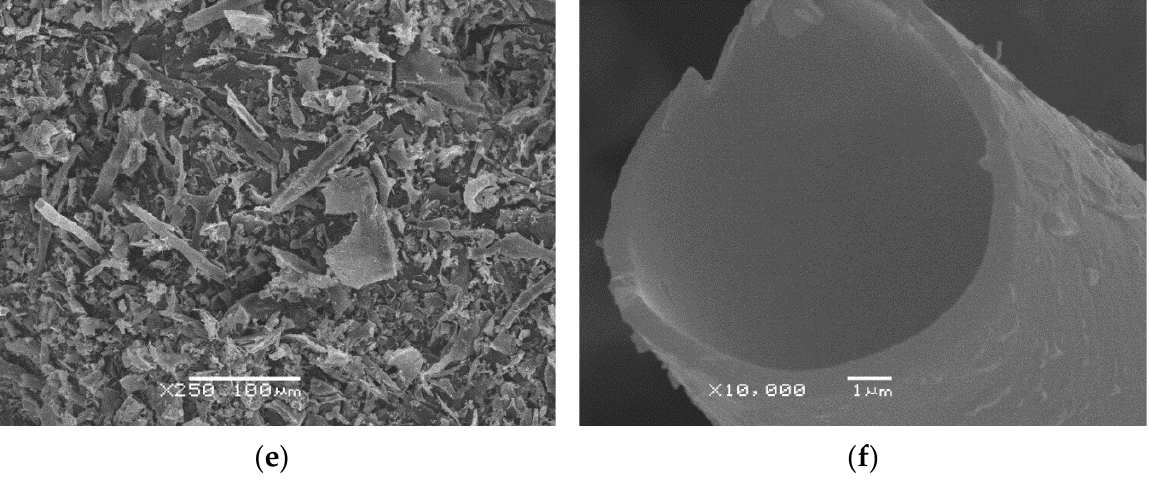
Figure 3. Photomicrography of different DHQ forms: ( a ) DHQ R at 250 × magnification; ( b ) DHQ R at 10,000 × magnification; ( c ) DHQ E at 250 × magnification; ( d ) DHQ E at 10,000 × magnification; ( e ) DHQ A at 250 × magnification; ( f ) DHQ A at 10,000 × magnification. The lyophilized samples were obtained from ethanol and acetonitrile solutions with 5% concertation of organic